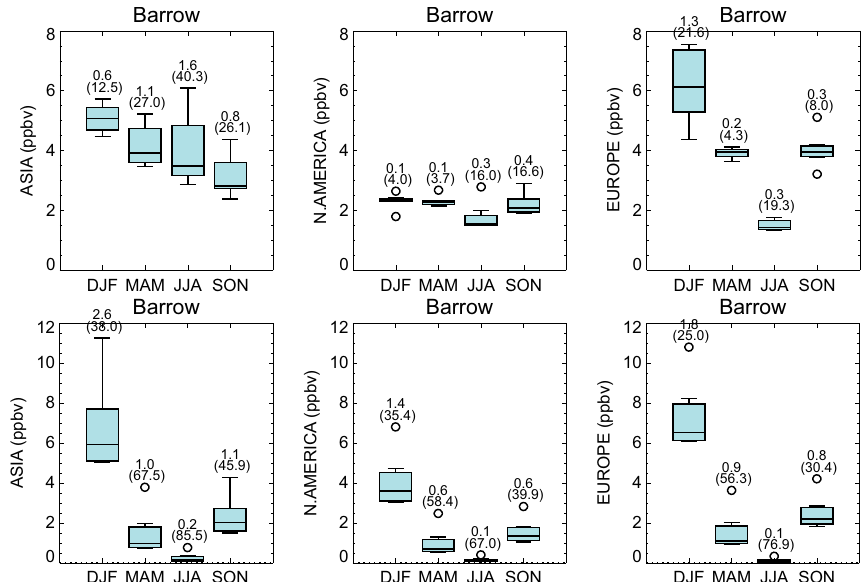
Figure 16. Box and whisker plots of the anthropogenic 25-day fixed-loss tracers (top) and the OH-loss tracers (bottom) at Barrow from 8 POLMIP models. The box and whisker plots show the minimum, 25th percentile, median, 75th percentile and maximum values of the sample. Outliers which are more than 1.5 × IQR from the 25th or 75th percentiles are shown by circles. The numbers on the plot represent the interquartile range as absolute concentrations and as a percent of the multi-model mean (in